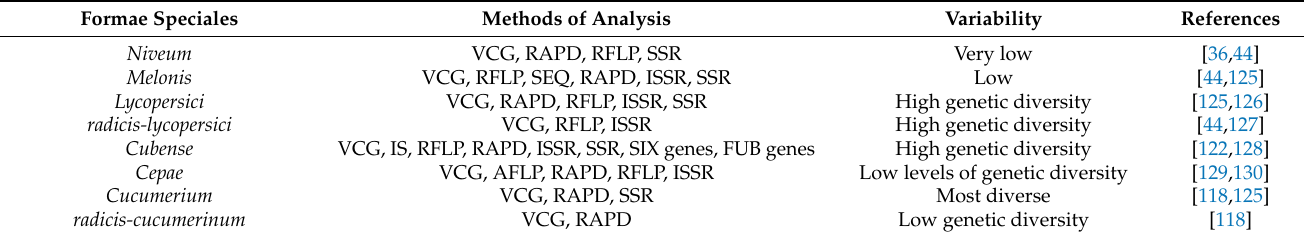
Table 4. Genetic variability studies on important formae speciales of Fusarium oxysporum . Formae Speciales Methods of Analysis